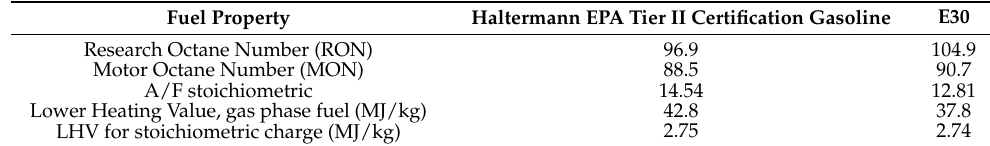
Table 3. Fuel properties for gasoline and E30 used in this work.